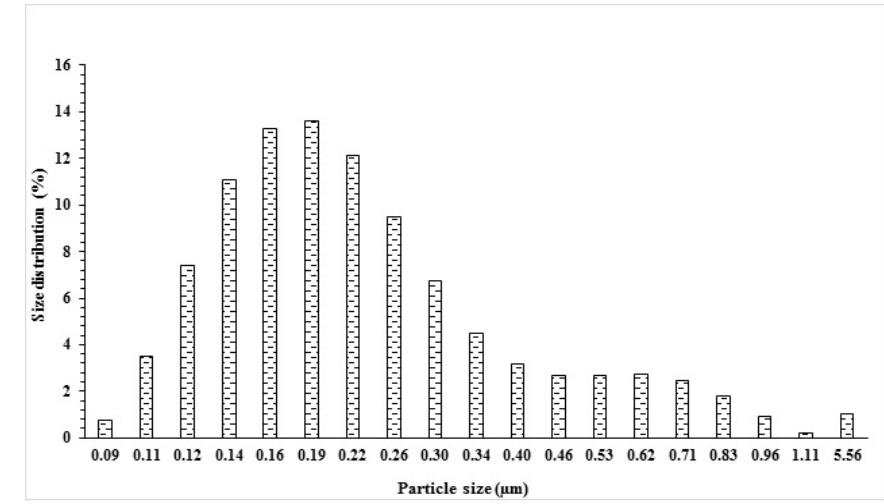
Figure 4. The size distribution of MA-AC400 particles in aqueous solution using dynamic light